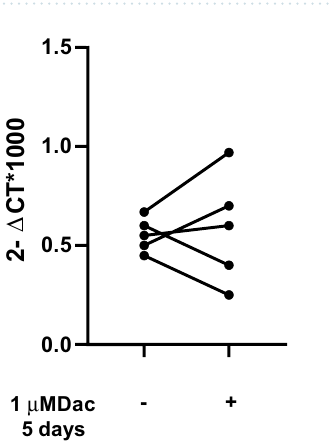
Figure 3. Correlation analysis of FOXM1 expression in MSC from patients with myeloid neoplasm and healthy donors. ( A ) Patient age, ( B ) FOXM1 target gene expression ( CCNB1, CDC20, NDC80, PLK1 ). Correlation was studied using a nonparametric Spearman correlation test. The relationship between two variables is generally considered strong when their r value is higher than 0.7. Pearson r > 0 indicates a positive association.